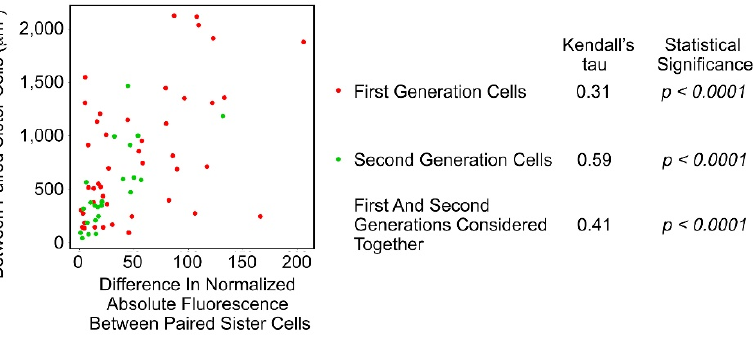
Figure 4. Scatterplot of the differences between paired sister SAOS-2 cells in cell-profile area against differences in fluorescence acquired from co-cultured HDFs. Data are from the same experiment, ‘a’, which is shown in Figure 3. There was correlation in both generations of cells studied, as well as when first and second generations were considered together.